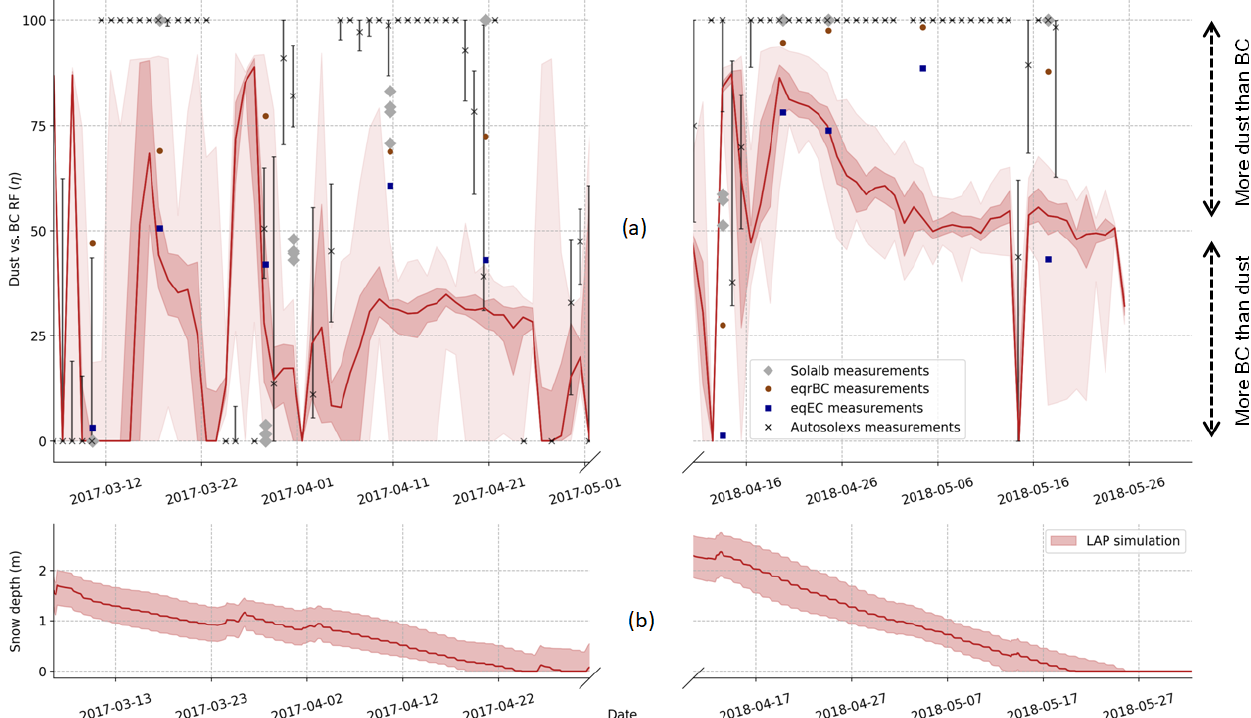
Figure 8. (a) Percentage of the LAP total RF which is caused by dust ( η ) during the final ablation period. The η values estimated from the LAP simulation are represented in red, with light shading corresponding to the full ensemble and darker shading corresponding to the first and third quartiles of the ensemble. Information retrieved from automatic spectral albedo is represented by black crosses with error bars corresponding to the 25% and 75% quartiles of all the measurements of the day. Information retrieved from manual spectral albedo is represented by grey diamonds. Chemical measurements of eqEC (EC + dust) and eqrBC (rBC + dust) are represented by dark blue and brown, respectively. The results are put in comparison to the snow depth (b) .